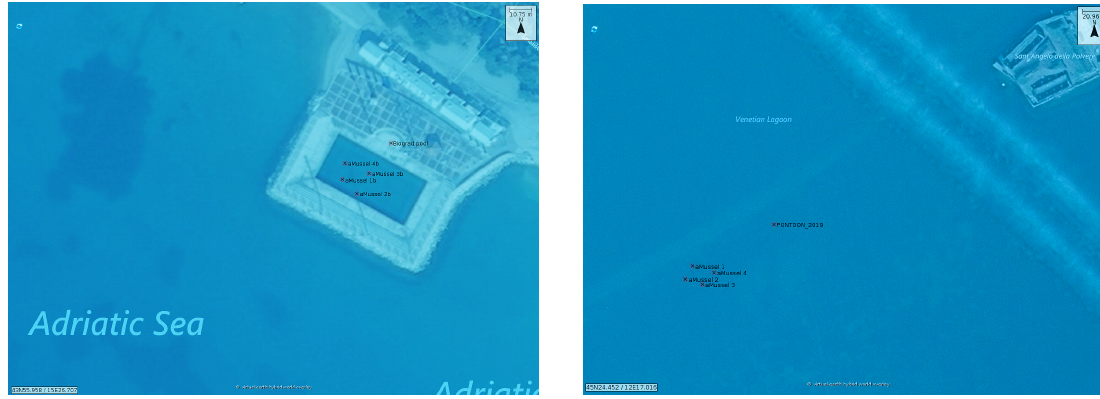
Figure 10. The two experimental areas: initial selected aMussel positions used in all experiments, overlaid on map with satellite image. Biograd na Moru, Croatia ( left ); Venetian Lagoon ( right